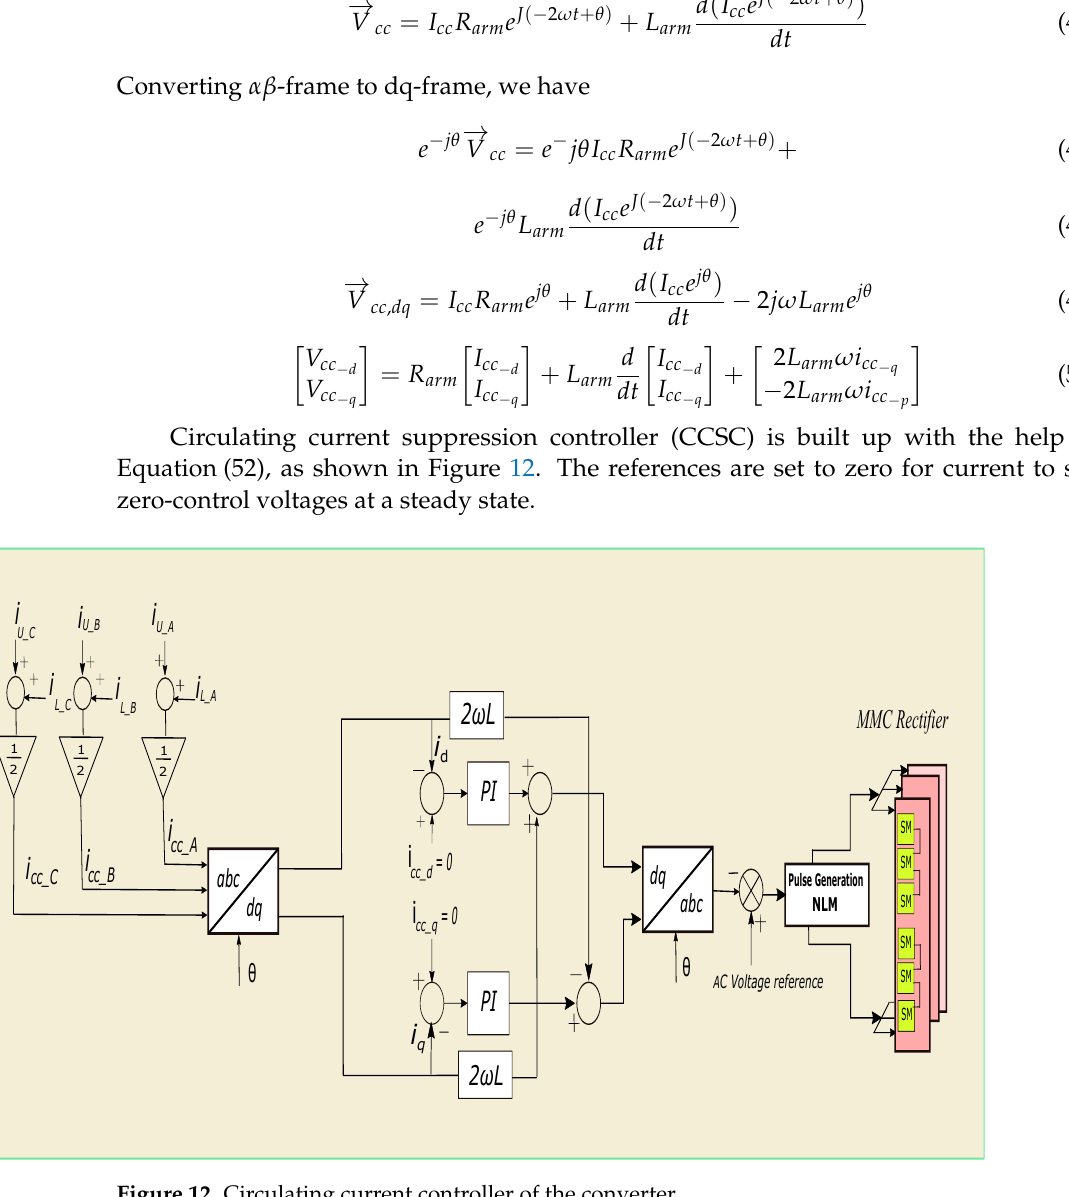
Figure 12. Circulating current controller of the